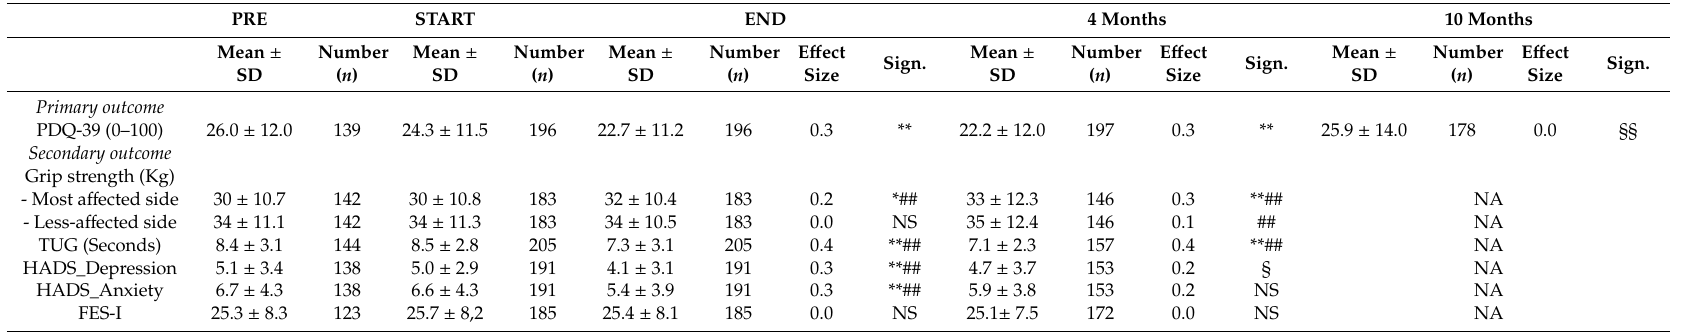
Table 4. Mean values for outcome